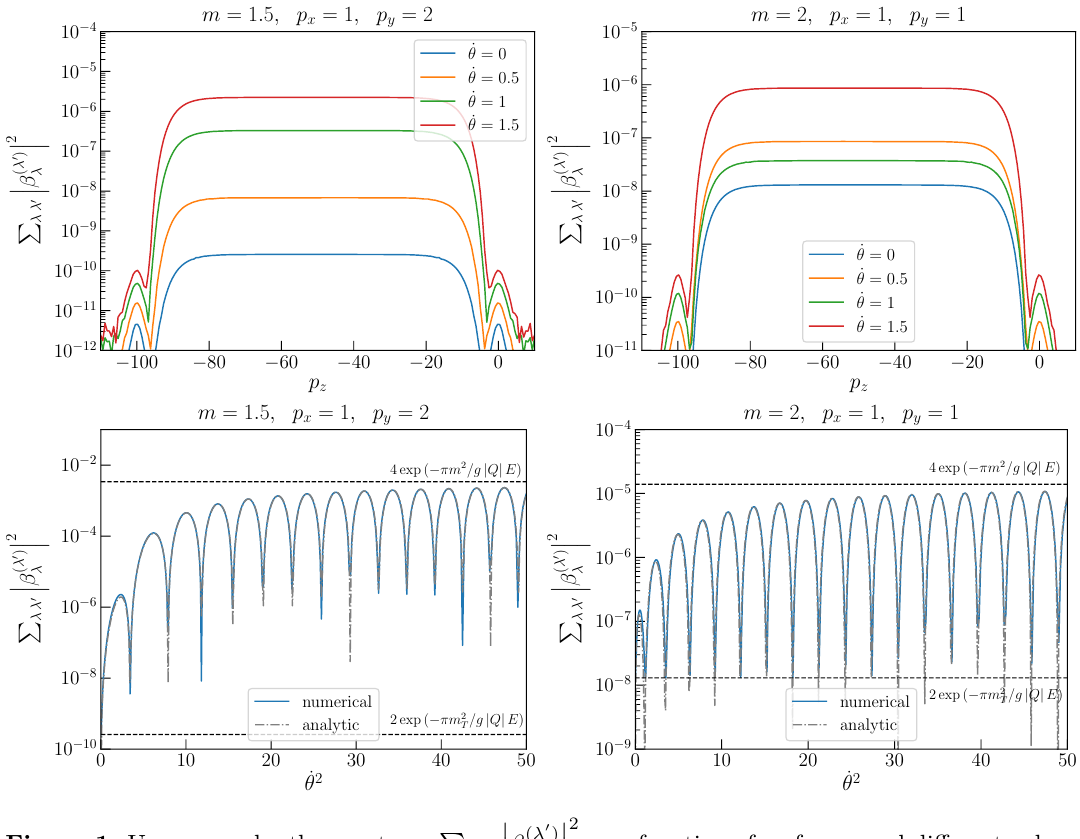
Figure 1 . Upper panels: the spectrum P of ˙ θ . Lower panels: the height of the plateau of the spectrum evaluated at p z = − 50 as a function of ˙ θ . The blue solid lines are the full numerical results, while the gray dashed lines are the analytical formula (2.24). The parameters are shown in the unit g | Q | E = 1 and for all figures in the paper we chose Q > 0